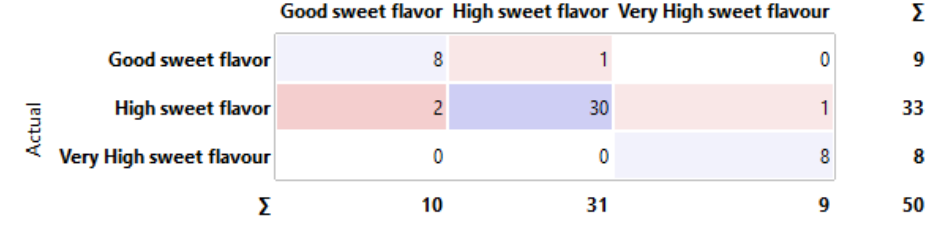
Figure 7. Confusion matrix of positive and negative results.